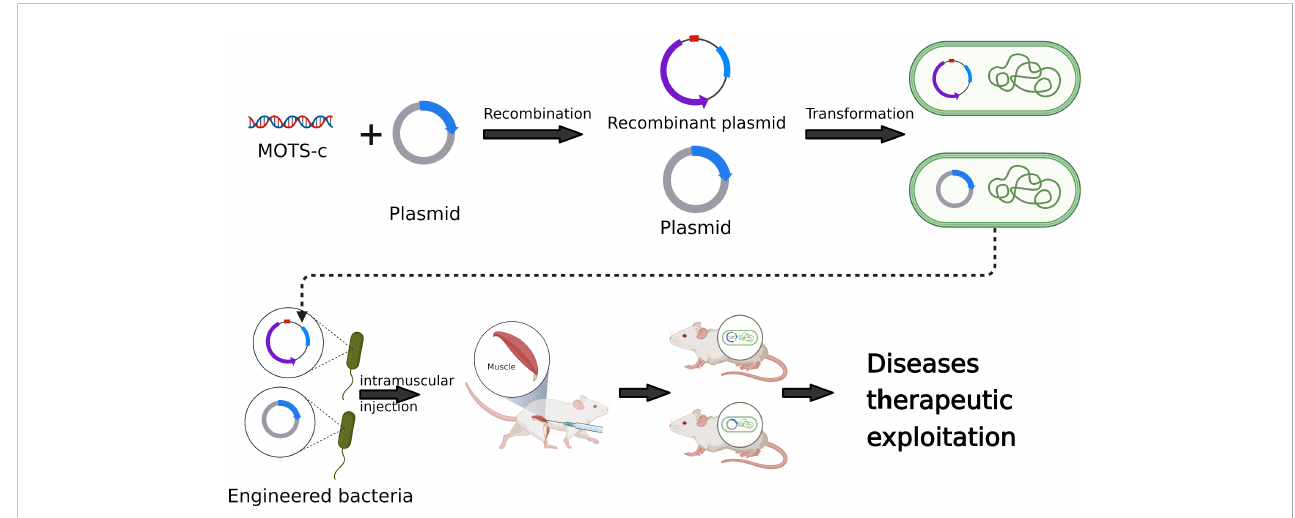
FIGURE 2 Development and application of MOTS-c in synthetic